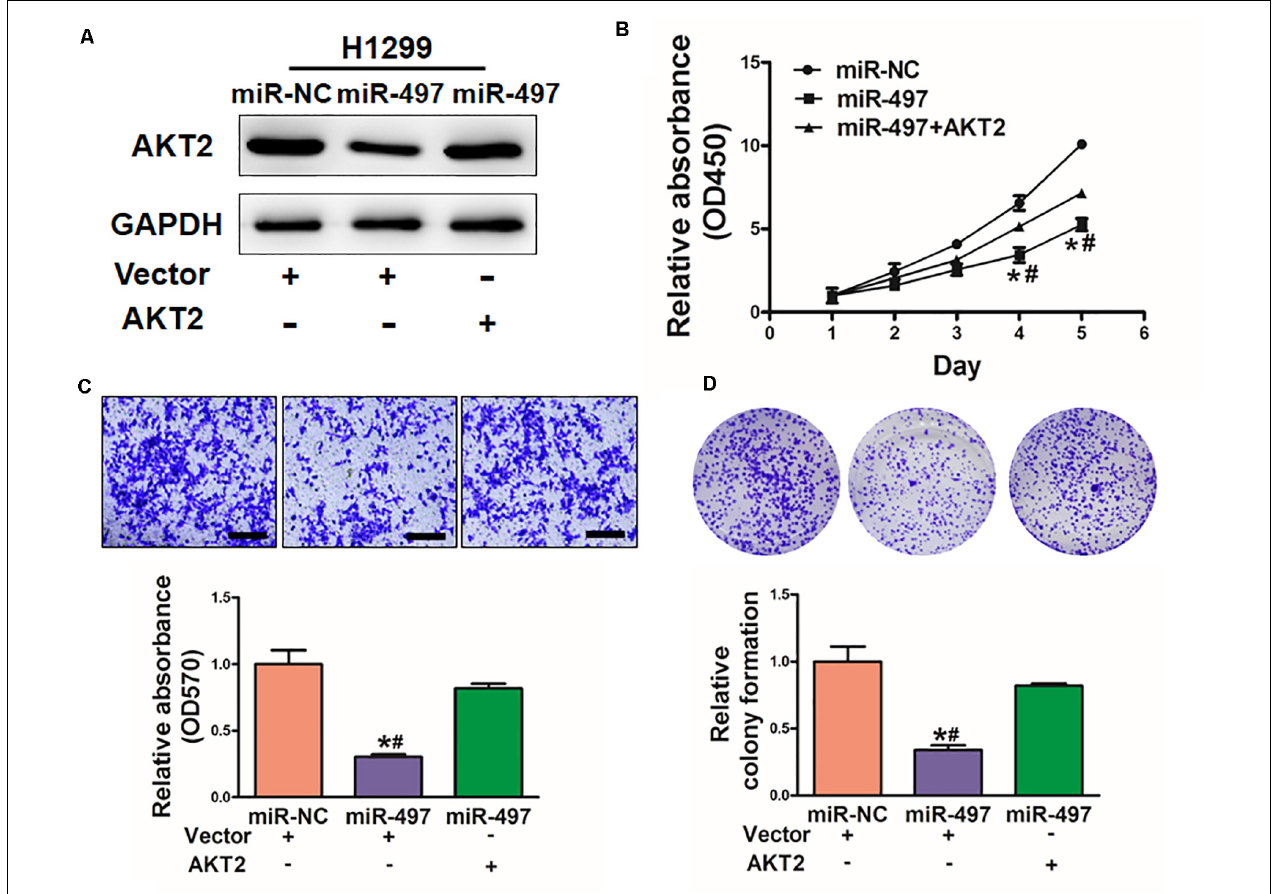
FIGURE 5 | Overexpression of AKT2 reverses the inhibitory effects of miR-497. (A) The expression of AKT2 was rescued by transfection of pCMV-AKT2 for 48 h. (B) Overexpression of miR-497 arrested cell proliferation, but this was rescued upon coexpression of exogenous AKT2 in H1299 cells. (C) MiR-497 overexpression decreased cell migration by its target AKT2 in H1299 cells. (D) Overexpression of AKT2 restored miR-497-inhibited colony formation. Data were presented by mean ± SD of 3 replicates. *or # indicated P < 0.05. *indicates significant difference compared to control; # indicates significant difference compared to miR-497 treatment plus